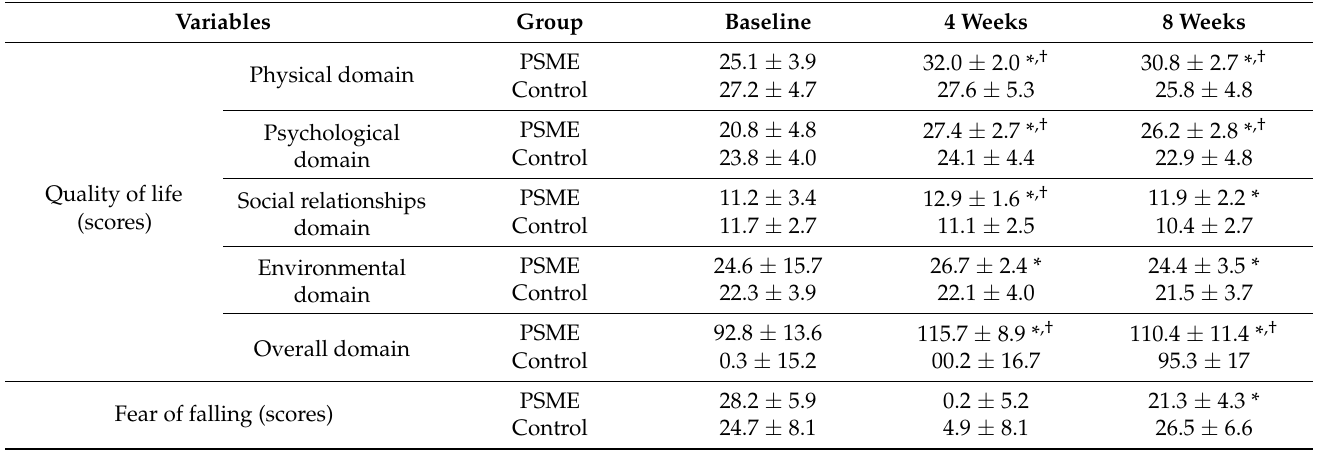
Table 5. The comparison of quality of life and fear of falling within the two groups at baseline, 4 weeks, and 8 weeks. Variables Group Baseline